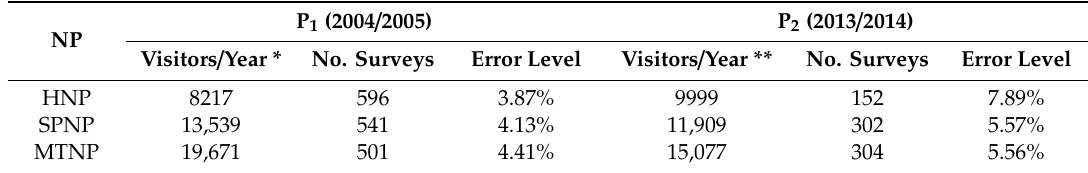
Table 2. Number of surveys for natural park (NP) and